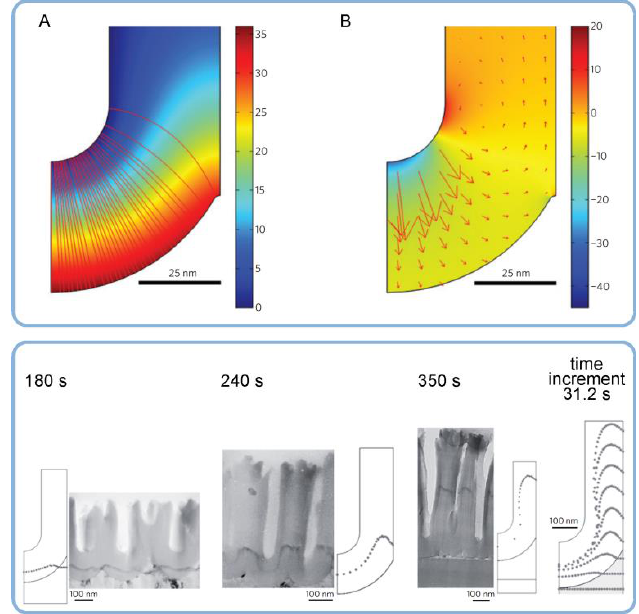
Figure 21. Top : the simulation results based on the viscous oxide flow model proposed by Houser and Hebert showing current lines and potential distribution ( A ) and velocity vectors and mean stress ( B ) during steady-state PAA growth. Bottom : a comparison of simulated tracer profiles from the work of Houser and Hebert and experimental ones taken from the earlier work by Skeldon et al. (Ref. [145]). Reproduced with permission from [144]. Copyright 2009 Nature.